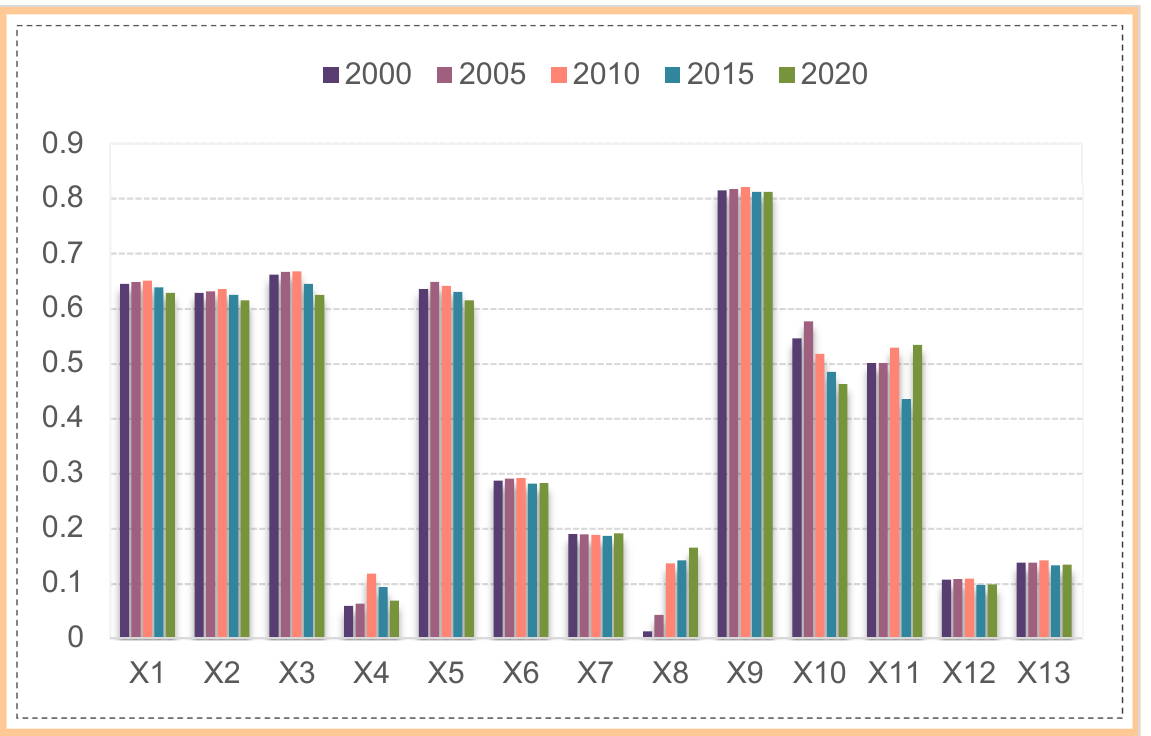
Figure 5. Results of impact factor detection for the spatial and temporal evolution of the EQI.